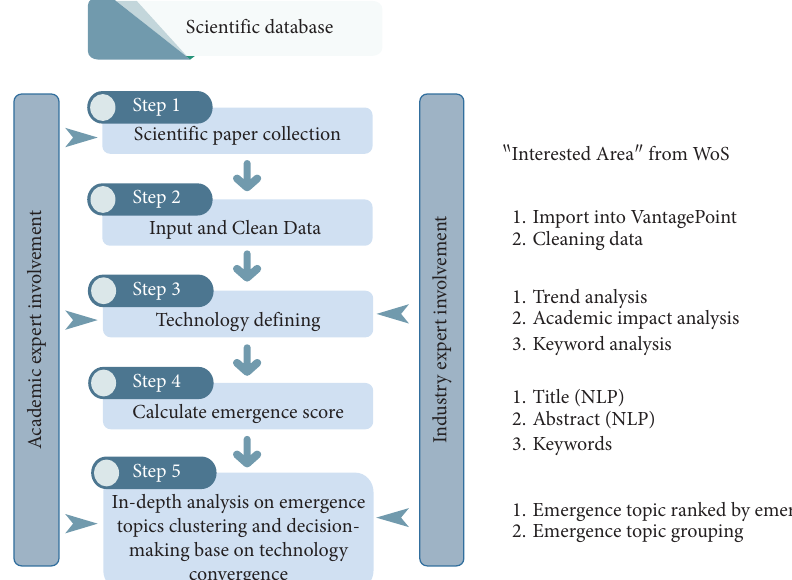
Figure 1: Research process for identifying chitosan